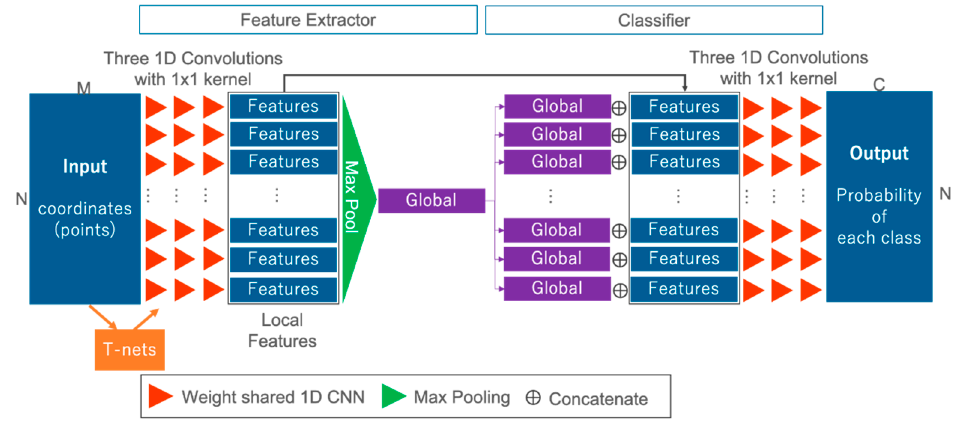
Figure 5. Geometry Model architecture. Input: coordinates (point cloud) data; output: class Figure5. GeometryModelarchitecture. Input: Coordinates(pointcloud)data; output: probability.